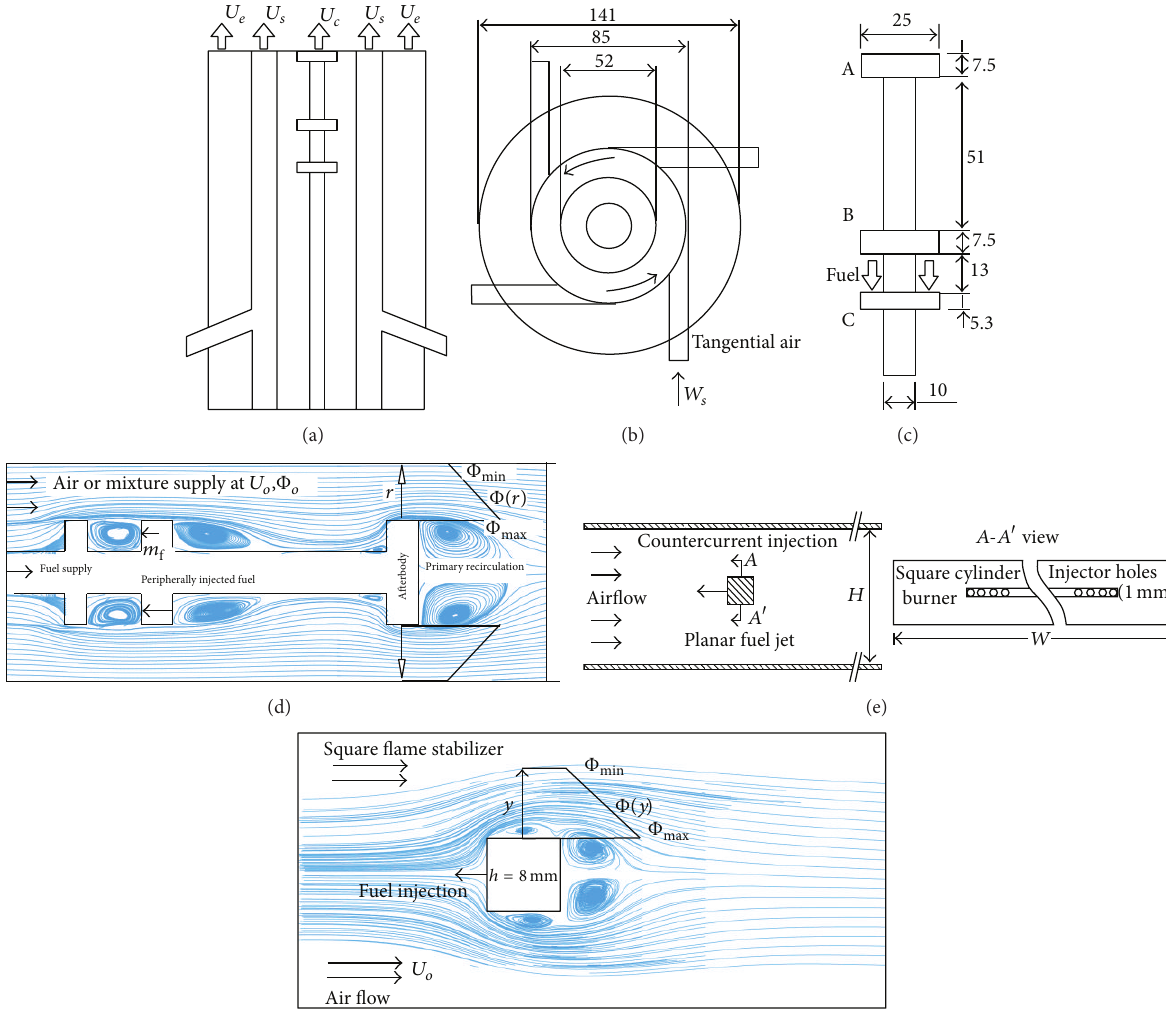
Figure 1: Axisymmetric disk ((a), (b), (c), and (d)) and slender square ((e), (f)) burner arrangements, including respective flow patterns, fuel-air placements, and mixture stratifications at inlet to the stabilization regions.